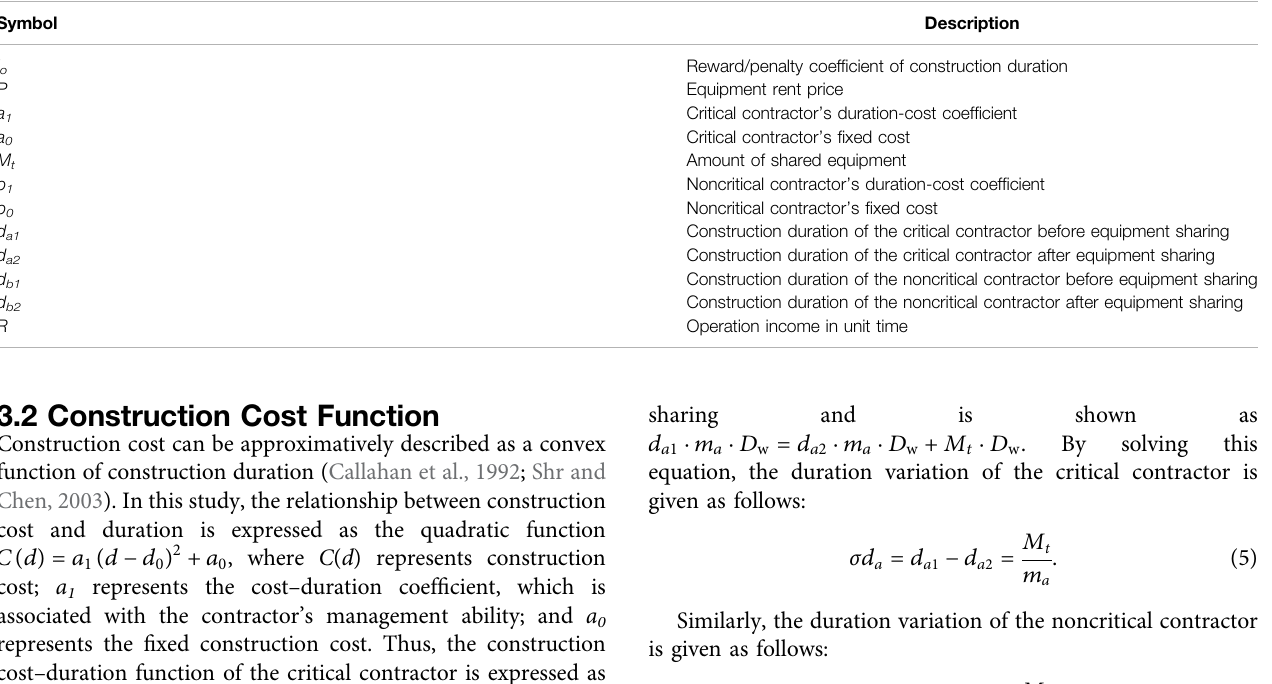
TABLE 1 | List of symbols and